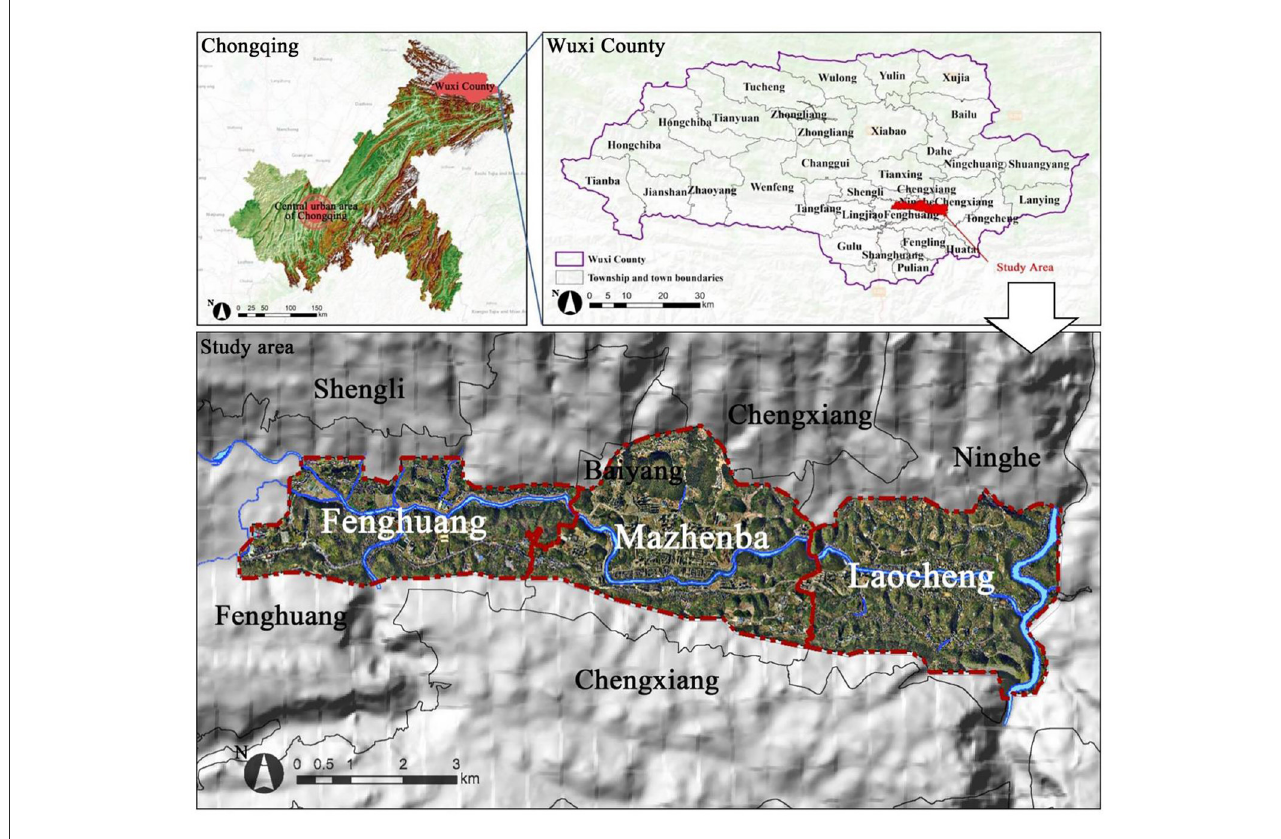
FIGURE1 Location of the study area.